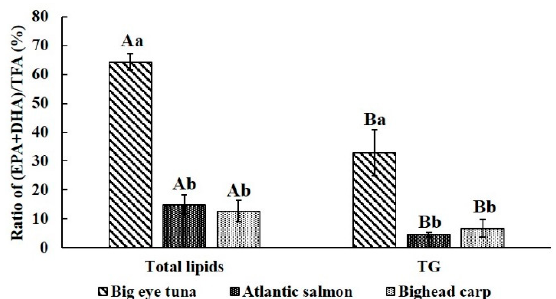
Figure 2. Ratio of (EPA + DHA) to TFA of total lipids and different classes of lipids. A,B means a significant difference of total lipids and TG fraction, a–c means a significant difference between the three different types of fish heads, p < 0.05.